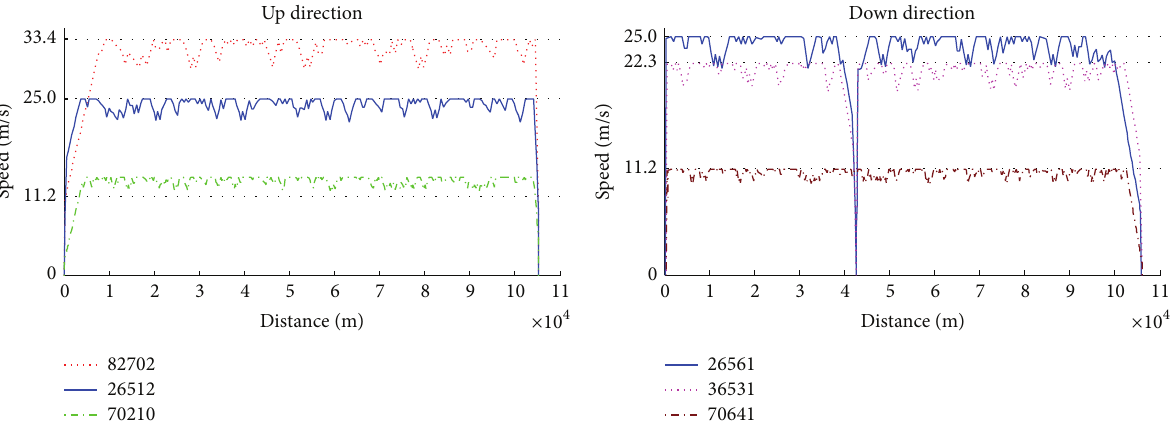
Figure 12: Train speed-distance curve (NCBS number: 2).